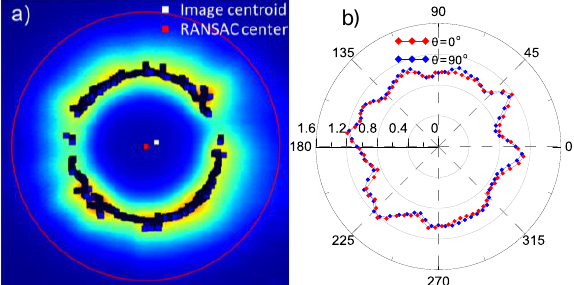
Fig. 7. PLIF-image (a) with identified center and radius and angular relative concentration profiles for 0° and 90° nozzle rotation angles (b). A 90° profile is revolved to match the orientation of 0°-profile for better comprehension.